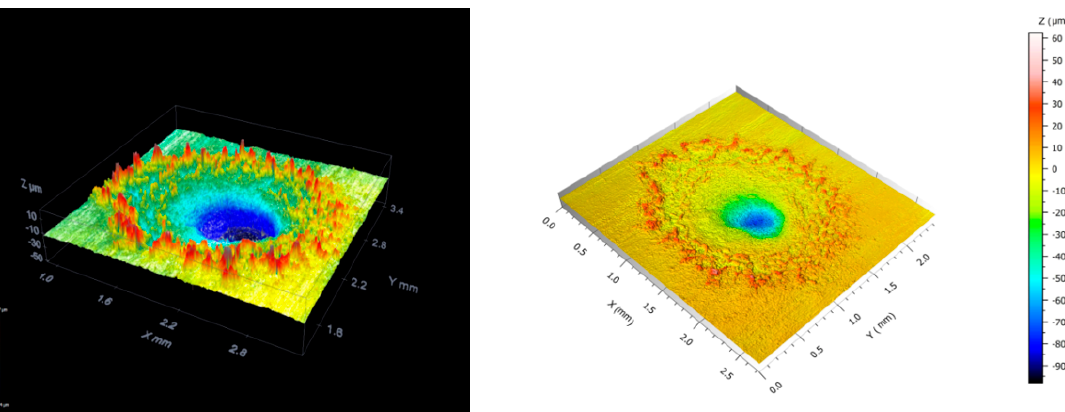
Figure 2. A typical surface change after an LSP experiment. Images obtained via scanning confocal microscopy.